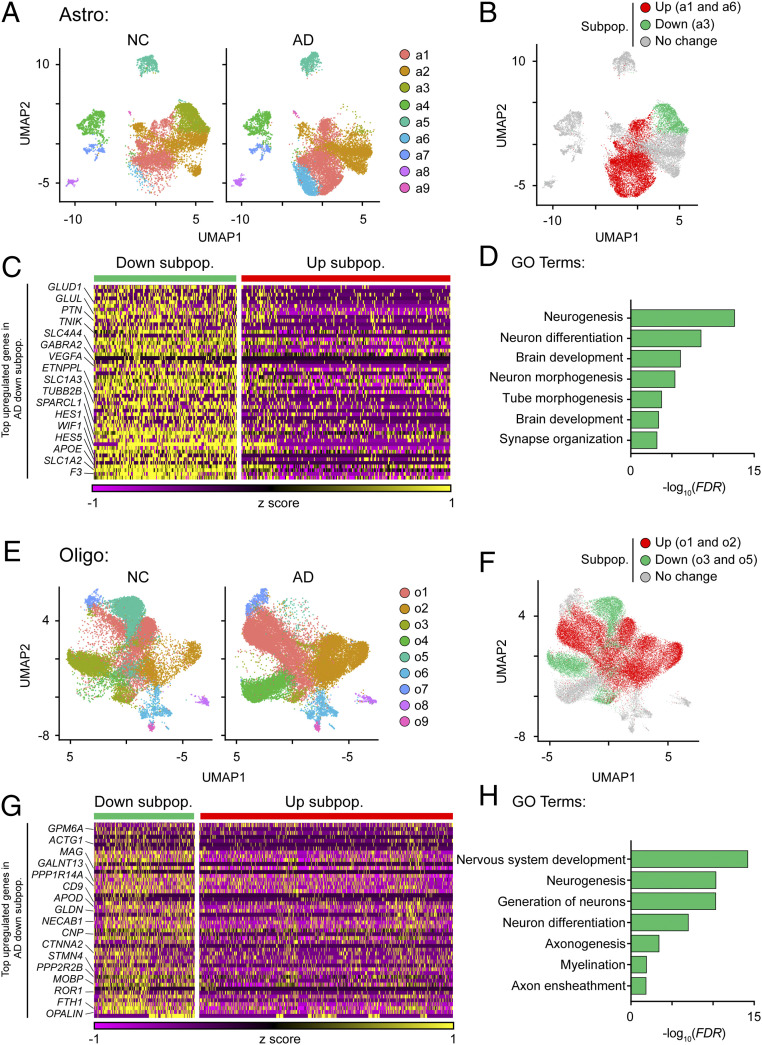
The proportions of astrocytes and oligodendrocytes that regulate neuronal homeostasis are reduced in AD. (A) UMAP plots showing the distributions of astrocyte subpopulations (a1–a9) in AD and NC prefrontal cortical samples. (B–D) The astrocyte subpopulation associated with the maintenance of synaptic functions was reduced in AD. (B) UMAP plot showing the distribution of the AD-associated astrocyte subpopulations. (C) Heatmap showing the expression levels of the top enriched genes in the AD-down-regulated astrocyte subpopulation (adjusted P < 0.1, log2 fold change ≥ 0.1). Down subpop.: down-regulated subpopulation; Up subpop.: up-regulated subpopulation. (D) GO pathway analysis of the transcriptomic signature of the AD-down-regulated astrocyte subpopulation. (E) UMAP plots showing the distributions of oligodendrocyte subpopulations (o1–o9) in AD and NC prefrontal cortical samples. (F–H) Oligodendrocyte subpopulations associated with myelination were reduced in AD. (F) UMAP plot showing the distribution of the AD-associated oligodendrocyte subpopulations. (G) Top enriched genes in the AD-down-regulated oligodendrocyte subpopulations (adjusted P < 0.1, log2 fold change ≥ 0.1). Down subpop.: down-regulated subpopulation; Up subpop.: up-regulated subpopulation. (H) Pathway analysis of the transcriptomic signature of the AD-down-regulated oligodendrocyte subpopulations. See also SI Appendix, Figs. S5 and S6 and Table S5.